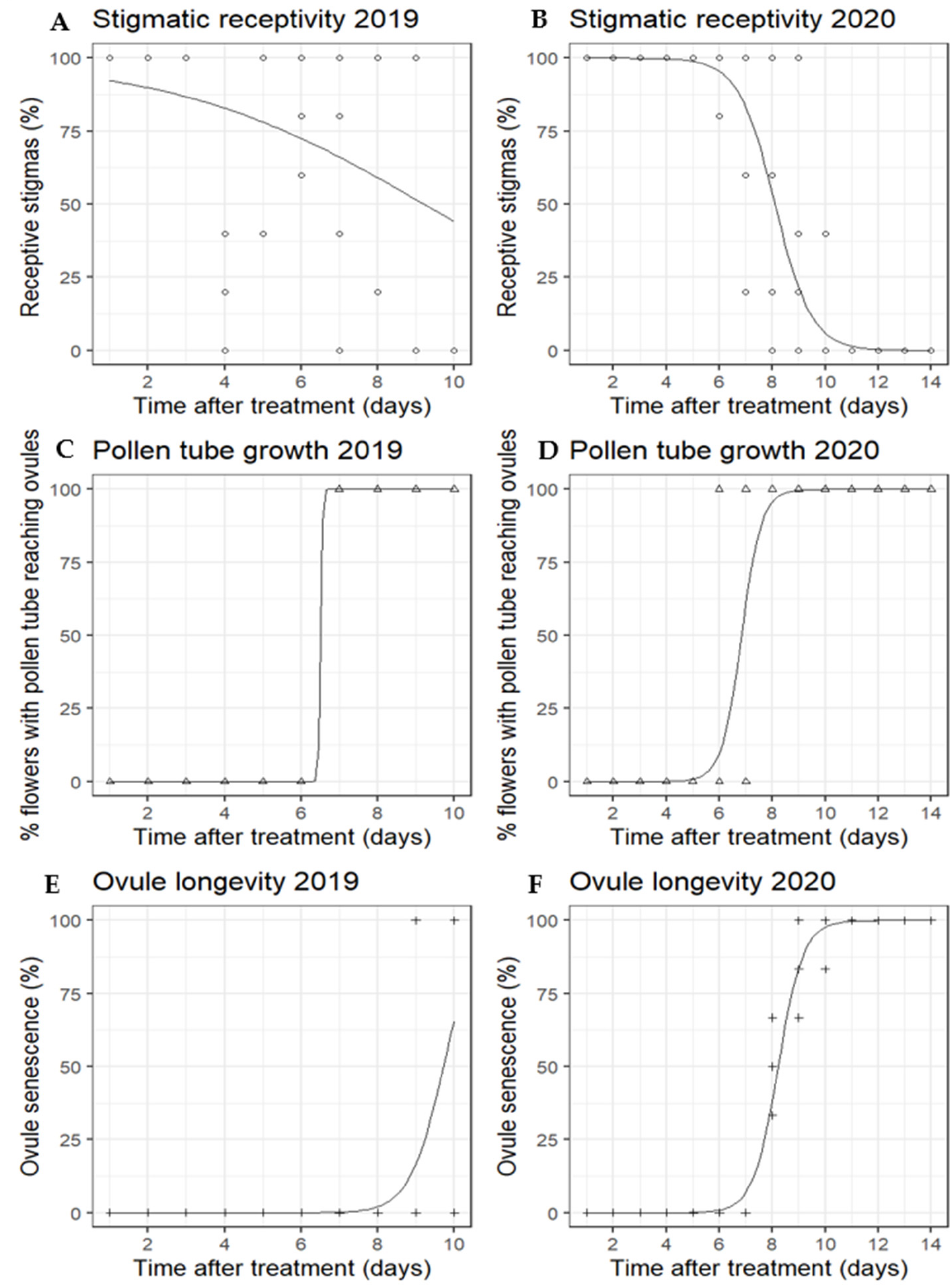
Figure 1. Scatter plots of ( A , B ) stigmatic receptivity, ( C , D ) pollen tube growth, and ( E , F ) ovule senescence with fitted regression curves. ( A , B ) are based on the stigmatic capacity to support adhesion and germinability. ( C , D) are based on the progression of pollen tube growth into the ovary and reaching the ovules. ( E , F ) are based on the duration of ovule viability. ( A , C , E ) represent 2019 data, while ( B , D , F ) represent 2020 data.